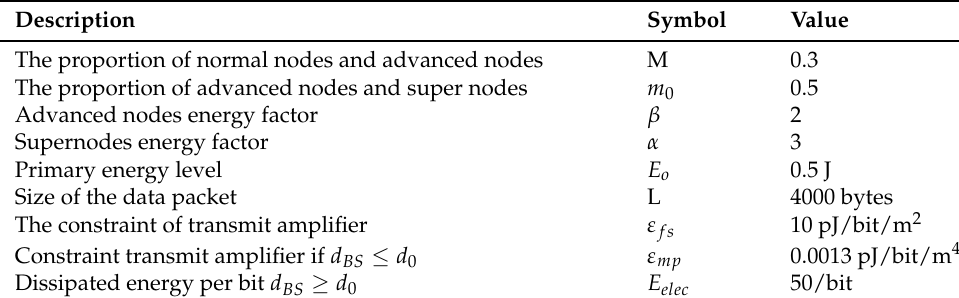
Table 1. Simulation parameters used for